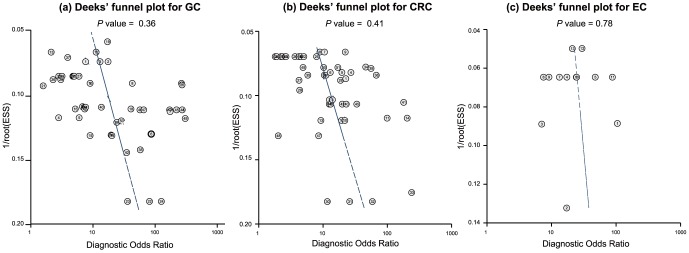
The Deeks' test of the diagnostic meta-analysis (a: Deeks' funnel for GC; b: Deeks' funnel for CRC; c: Deeks' funnel for EC.The dotted line indicates the regression line. No publication bias was detected for this meta-analysis (GC: P = 0.38; CRC: P = 0.41; EC: P = 0.78).